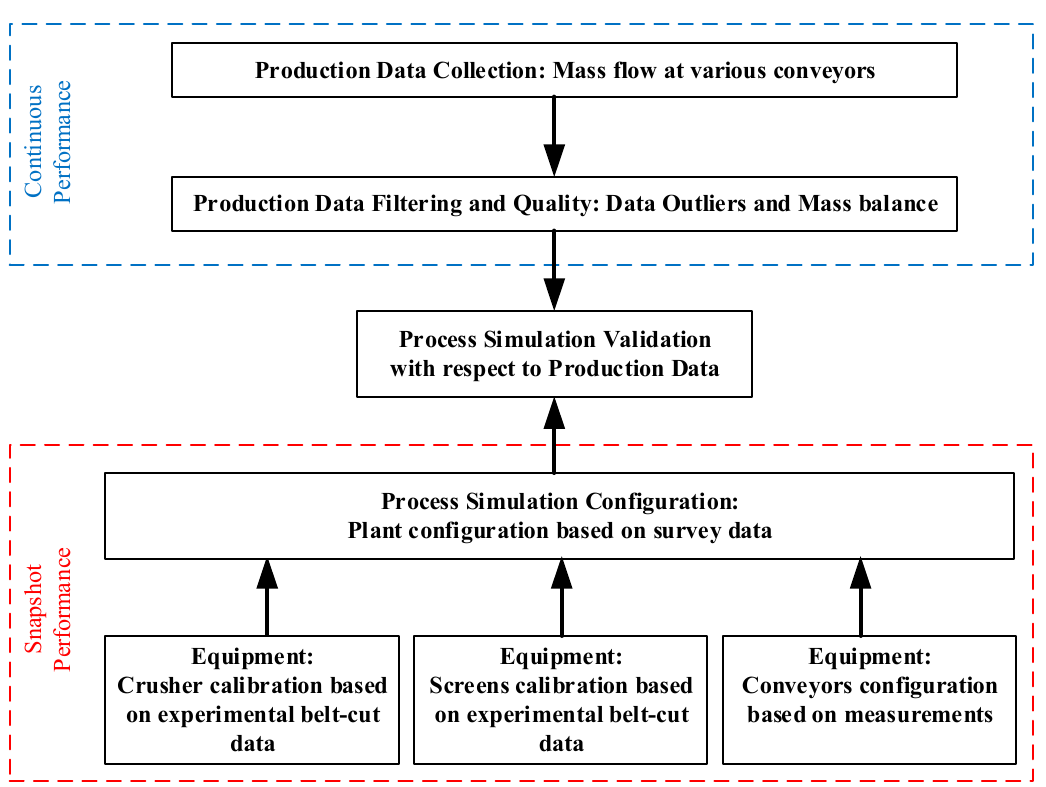
Figure 8. The steps for calibration and validation of dynamic process simulation of the crushing plant.